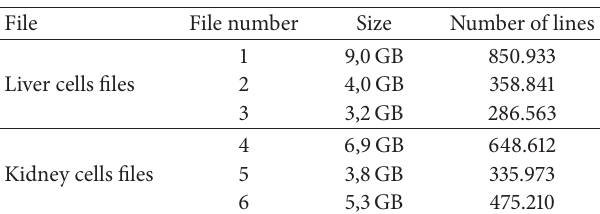
Table 1: Cells files.